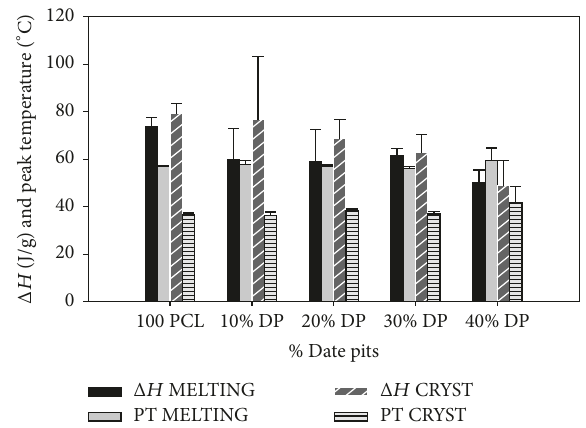
Figure 5: Effect of date pits on the Δ𝐻 and peak temperature of melting and crystallization of